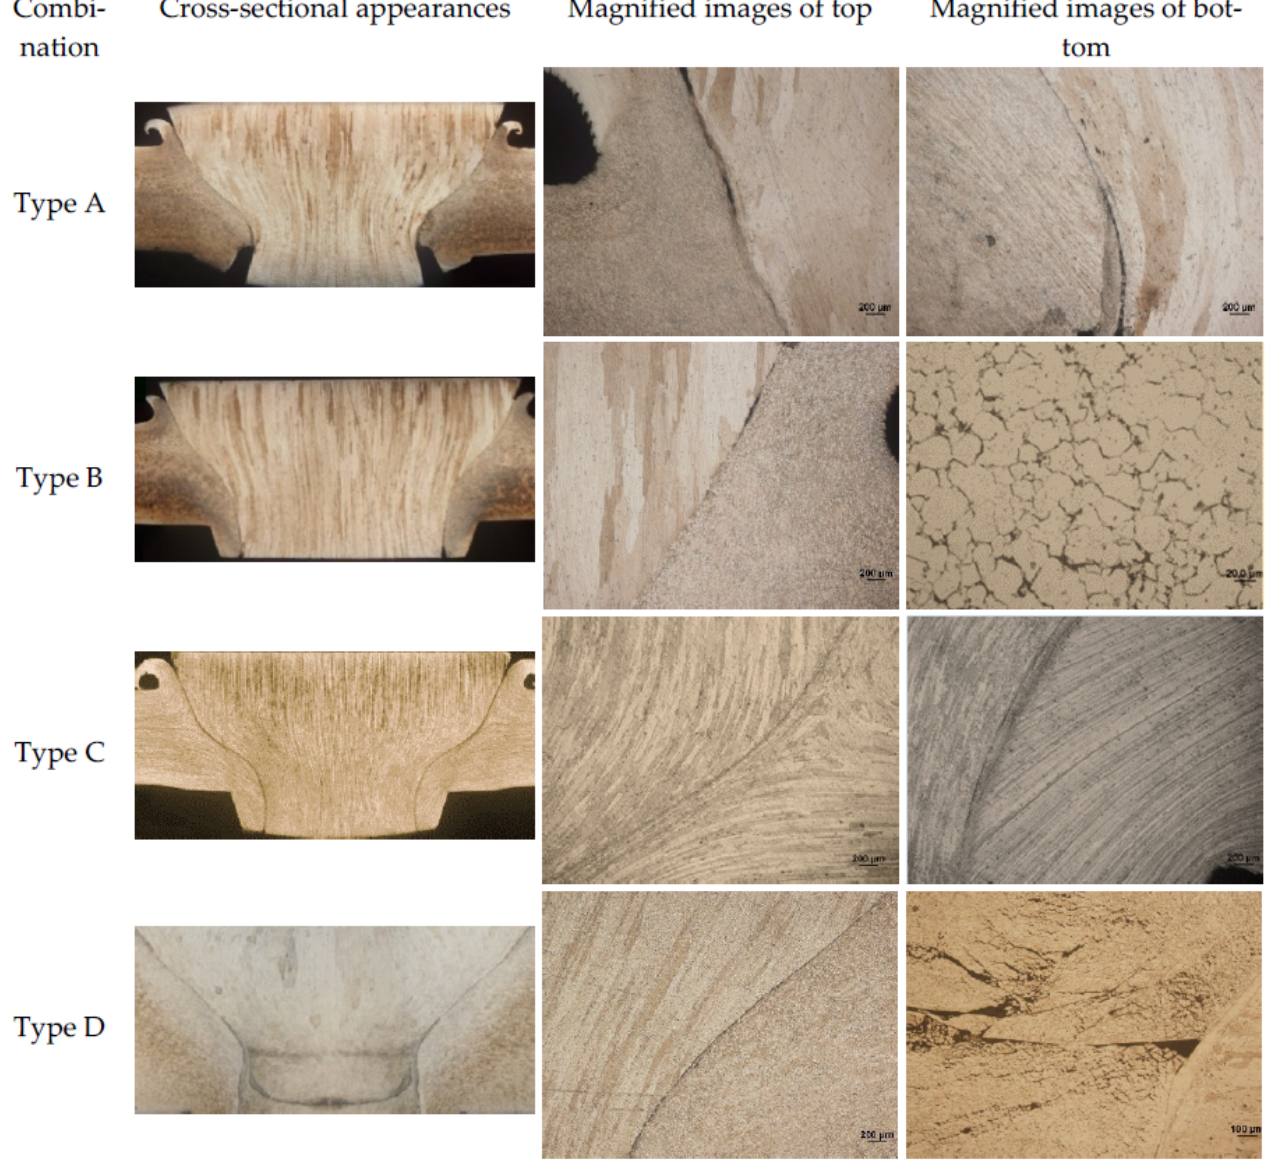
Figure 4. Macroappearance and defects of FPW joint.